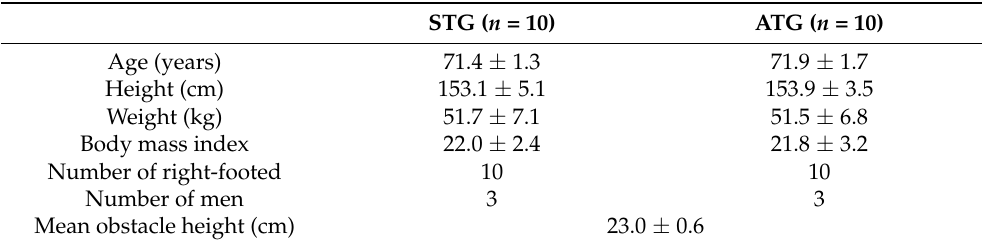
Figure 1. Participant flowchart from enrollment to intervention and experiment. Table 1. Participants’ characteristics.